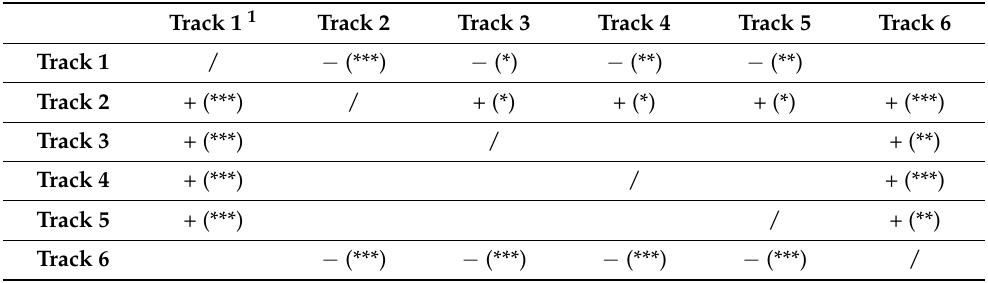
Table 8. The comparison of track numbers’ influence on paddle frequency between Q2 and Q3.